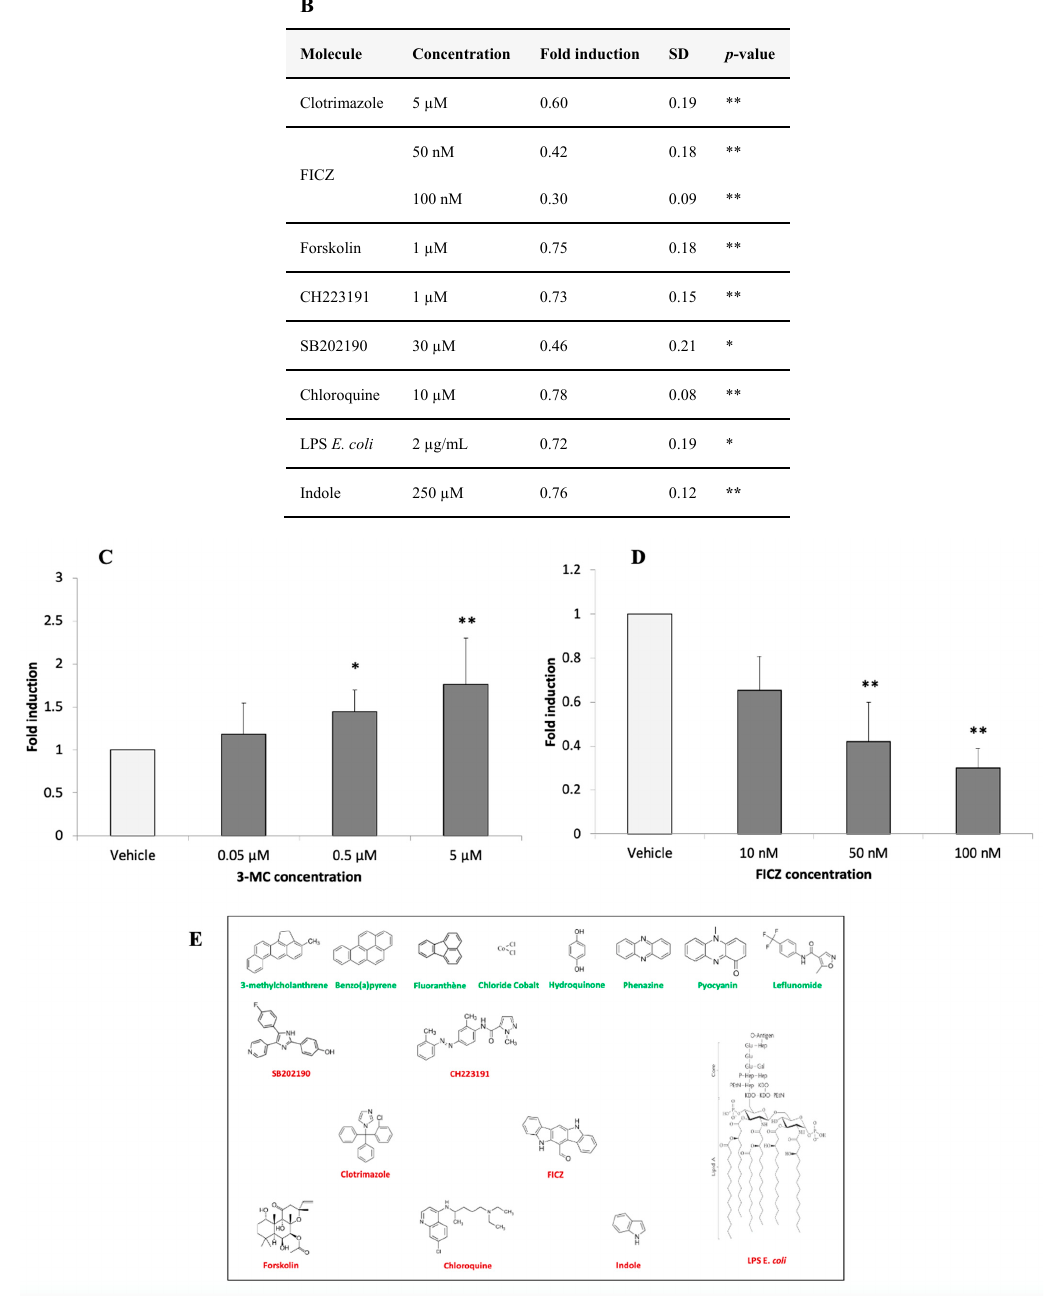
Figure 5. Summary of significant AHR-1 modulators in Cos-7 cells. Positive ( A ) and negative ( B ) modulator’s concentrations are represented with the dependent-AHR-1 fold induction of Firefly luciferase. Example of a positive ( C ), and negative ( D ) modulator dependent concentration effect on AHR-1 activity. Six independent experiments were performed in duplicate, fold induction is standardized to the vehicle which is 1. Statistical significances relative to the vehicle were examined: * p -value < 0.05; ** p -value < 0.01; *** p -value < 0.001. ( E ) Molecular structure of the positive (green) and negative (red) modulators of